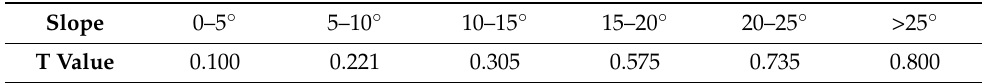
Table A3. T factor value under different slope